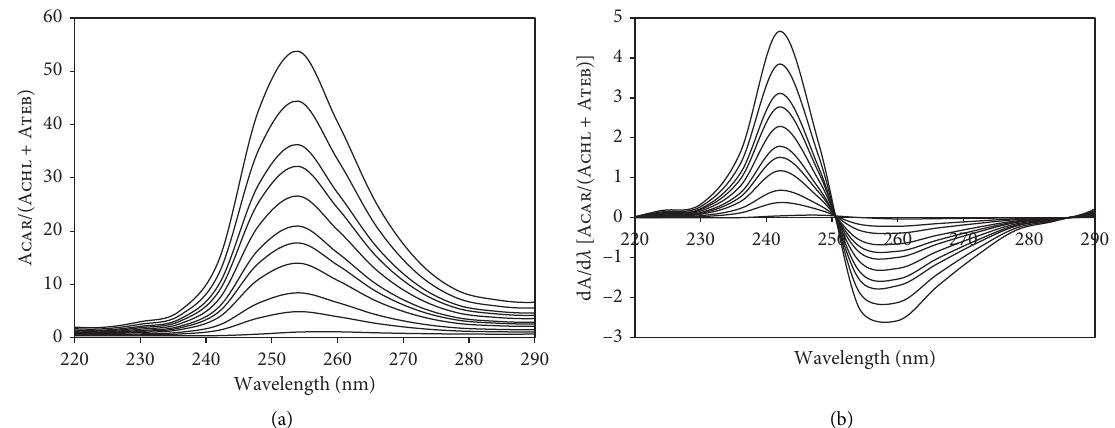
Figure 6: (a) Ratio spectra and (b) first derivative of the ratio spectra of CAR (1, 3, 5, 8, 10, 12, 15, 18, 20, 25, and 30 μ g/mL) using 10 μ g/mL CHL +10 μ g/mL TEB as a double divisor in methanol at Δ λ � 6.